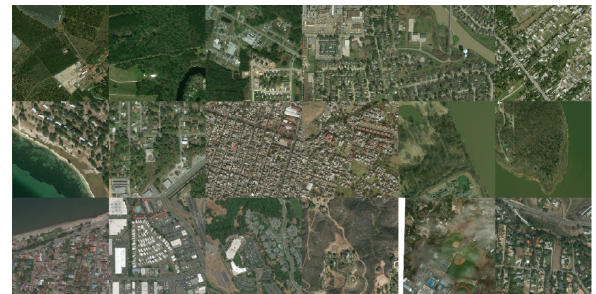
Figure 1. Pre-disaster xView2 images